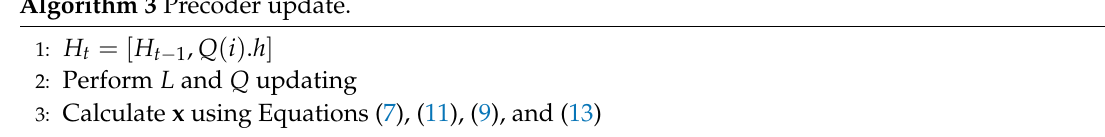
Algorithm 3 Precoder